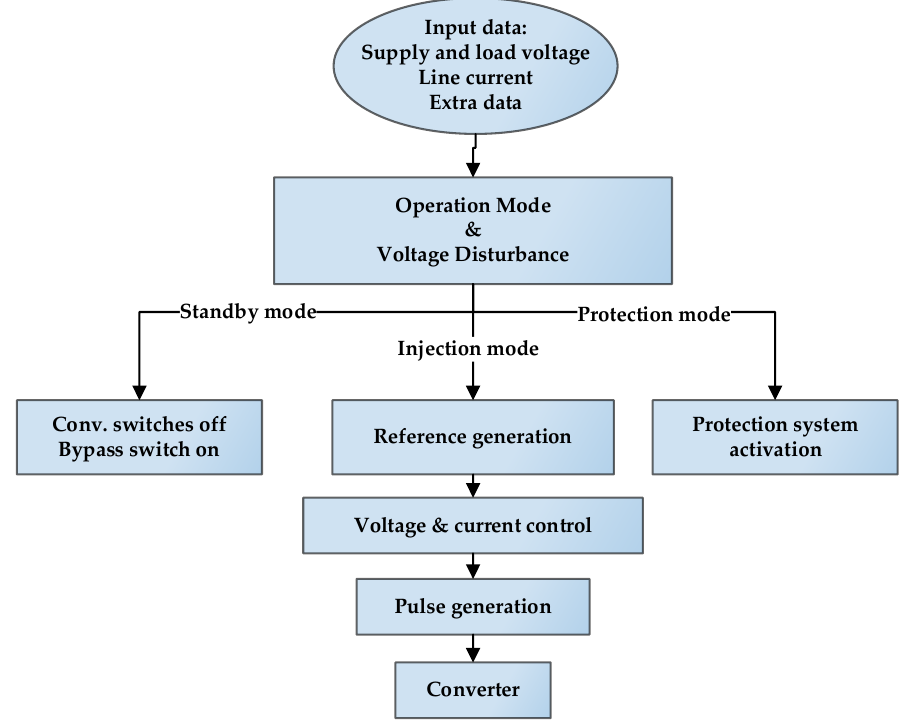
Figure 9. Different stages of the control unit in the DVR. Based on data from [7,42,69,94 – 170]. Figure 9. Di ff erent stages of the control unit in the DVR. Based on data from